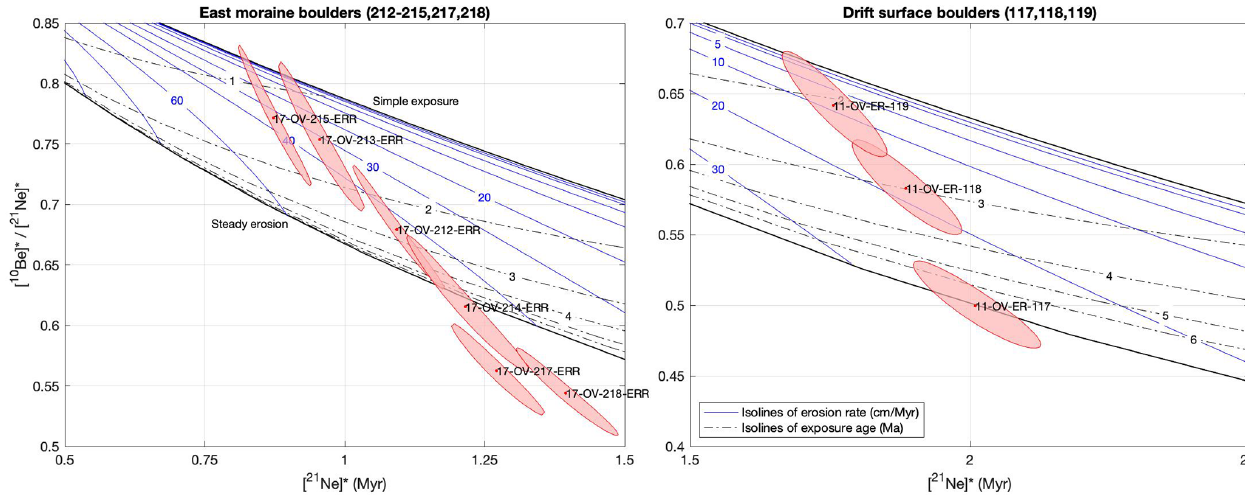
Figure 11. 10 Be– 21 Ne paired-nuclide diagram of the boulder samples. Solid black lines are the simple exposure line and steady-state erosion line, which marks the zone of continuous exposure. Blue lines are isolines of constant steady erosion (cmMyr − 1 ), and dashed black lines are isolines of constant exposure age (Myr). The measured nuclide concentration for each sample is represented by a red dot with red shading of its 1 σ uncertainty. ∗ signifies nuclide concentrations normalized to respective surface production rate.